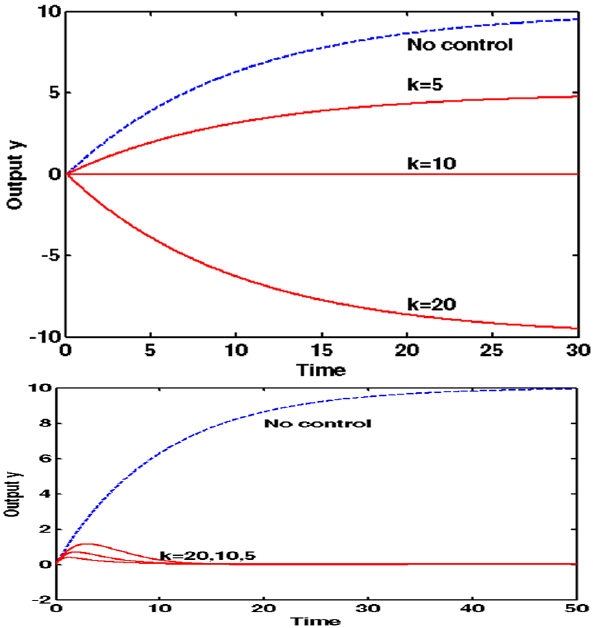
Figure 3: The magic of feedback! Comparison of feedforward and feedback control with respect (cid:44) to gain error. Nominal gain is k = 10 . Top: Feedforward control. Bottom: Feedback con- trol.